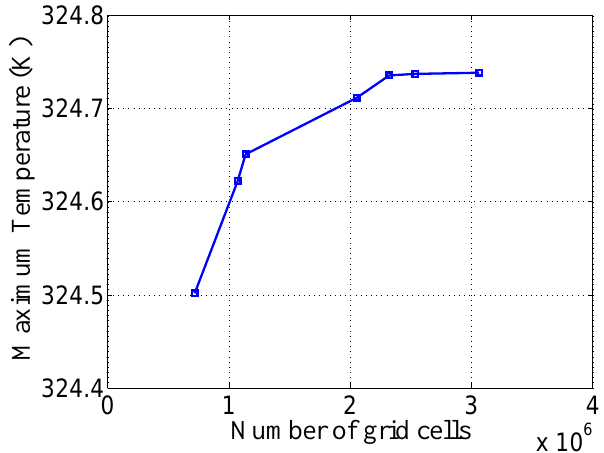
Figure 3. Grid dependence analysis result.